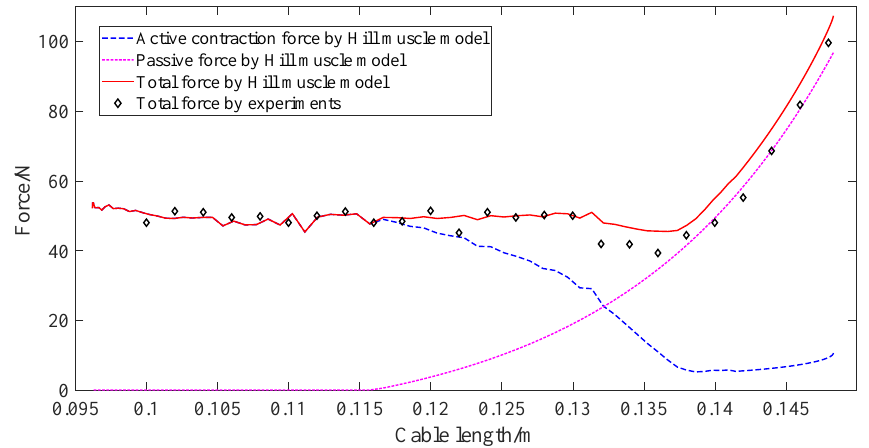
Figure 15. Active contraction experimental verification.